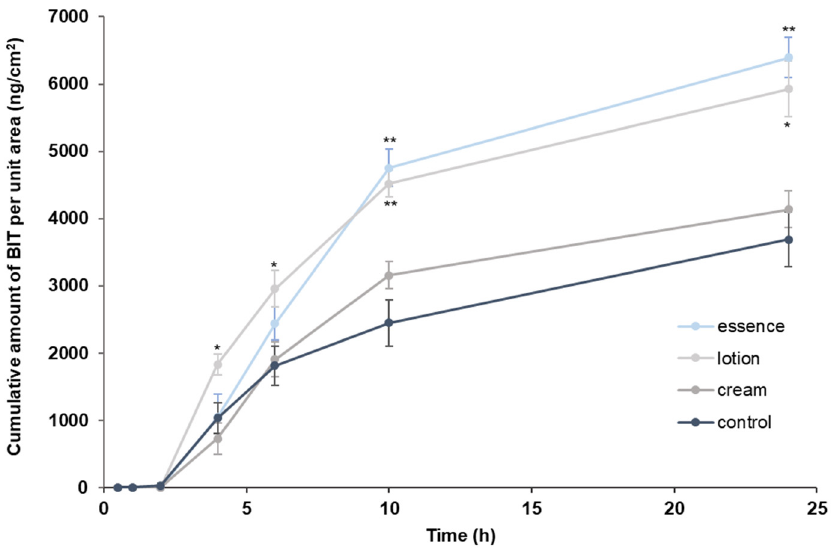
Figure 4. Cumulative absorption profile of BIT applied as a finite dose (10 µ g/cm 2 ) in minipig skin for 24 h after pretreating cosmetics (30 min, 30 mg/cm 2 ). Values are mean ± SE for 3 cells. * p < 0.05, ** p < 0.01 by Student’s t -test.